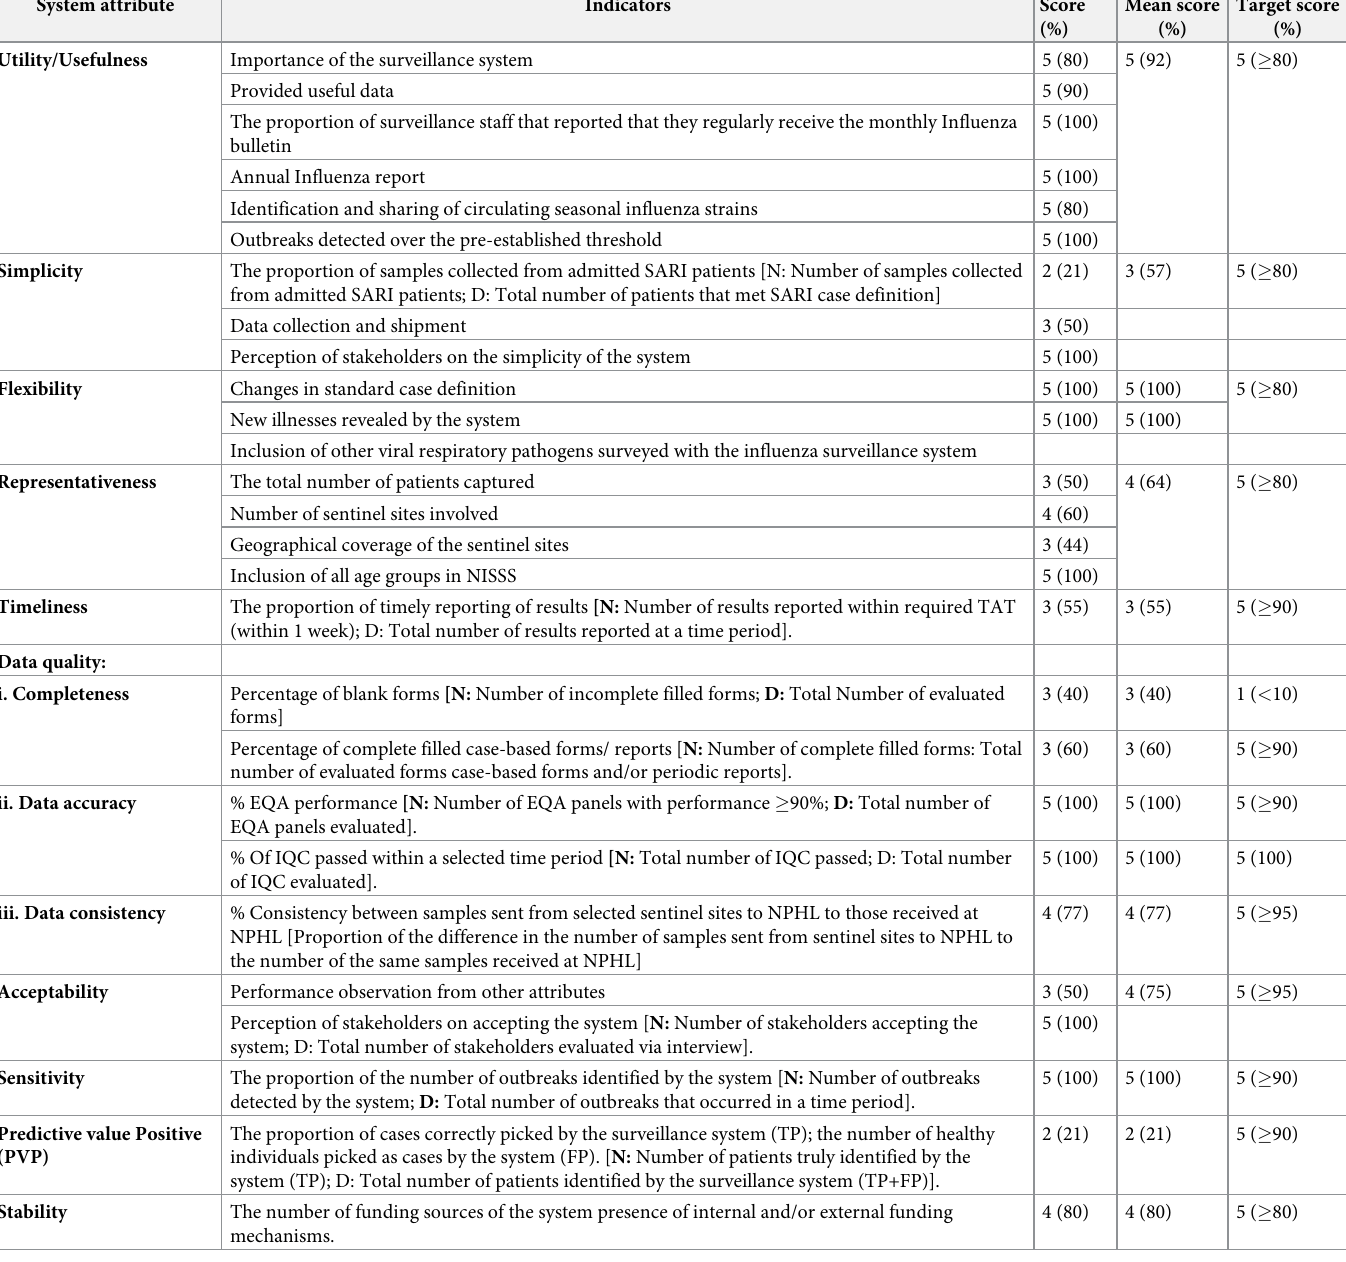
Table 3. Findings from the evaluation of the National Influenza Sentinel Surveillance System in